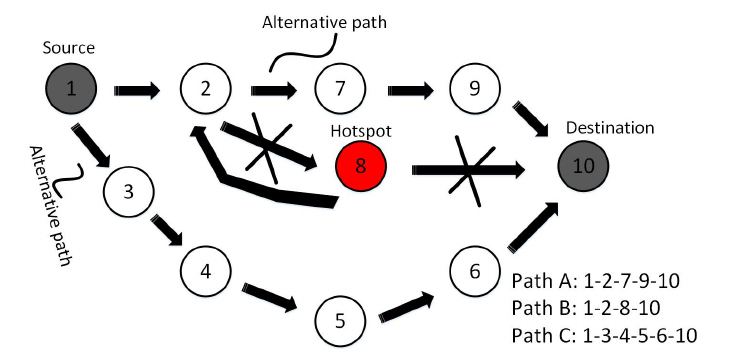
Figure 4. Hot Spot creation in IoT Network: A glimpse of a normal communication taking place in the network. The path from source to destination is selected for communication. The red node represents hotspot node that has a high temperature. Whenever the packet will be transferred to hotspot node, it will backtrack the packet to the previous node.